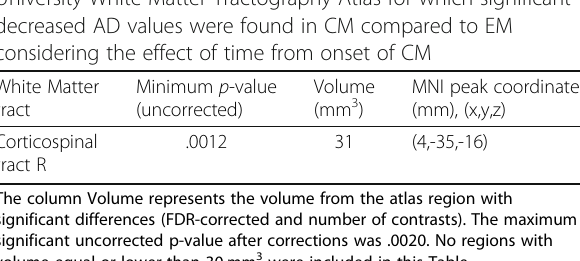
The column Volume represents the volume from the atlas region with significant differences (FDR-corrected and number of contrasts). The maximum significant uncorrected p-value after corrections was .0020. No regions with volume equal or lower than 30mm 3 were included in this Table R Right